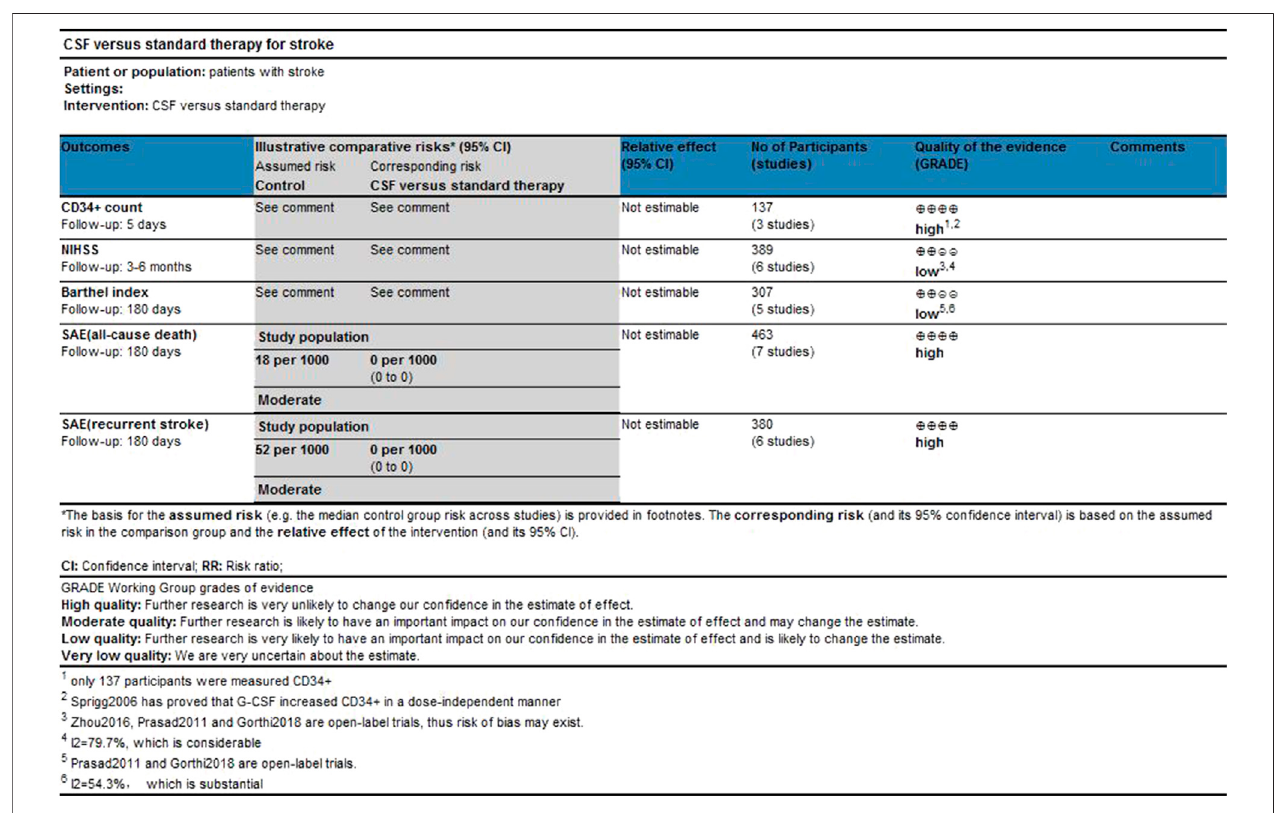
FIGURE 4 | Gradepro